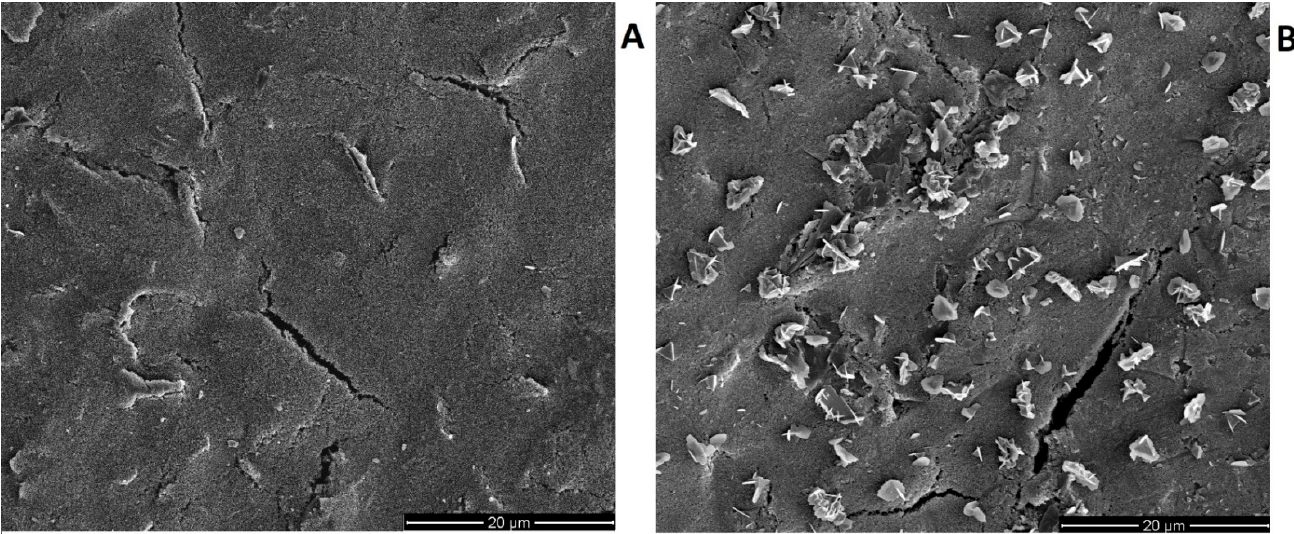
Figure 8. Images obtained through scanning electron microscope for the bare ( A ) and modified with copper film ( B ) CN/SPE working electrode. Copper film modified electrode was prepared in situ from the water solution containing 0.1 M HCl and 2 × 10 –4 M Cu(II).